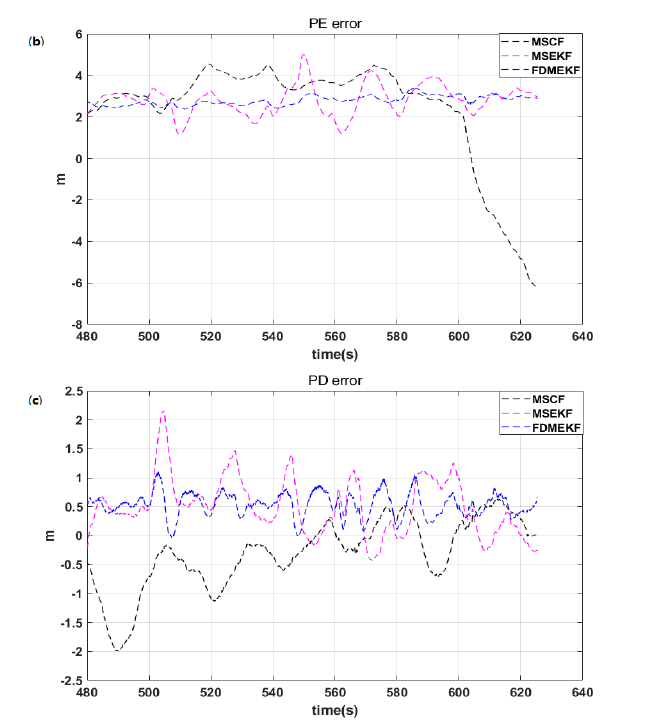
Figure 12. The position error of the UAV in flight. ( a ) the north position error of the UAV; ( b ) the east position error of the UAV; ( c ) the down position error of the UAV.